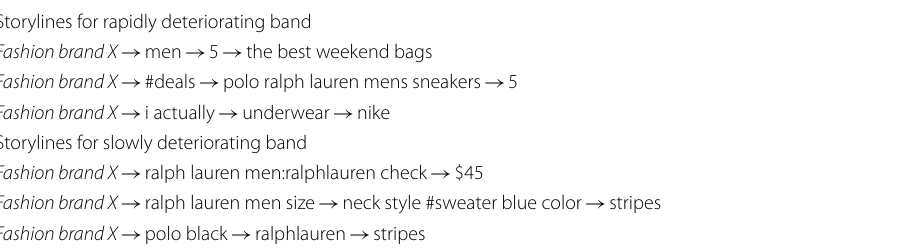
and slowly deteriorating